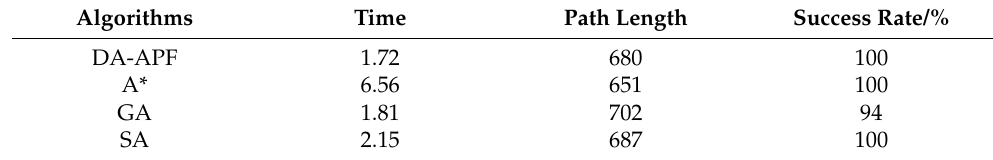
Table 3. Performance results for Environment III (mean values from 50 runs for all algorithms). Algorithms Time Path Length Success